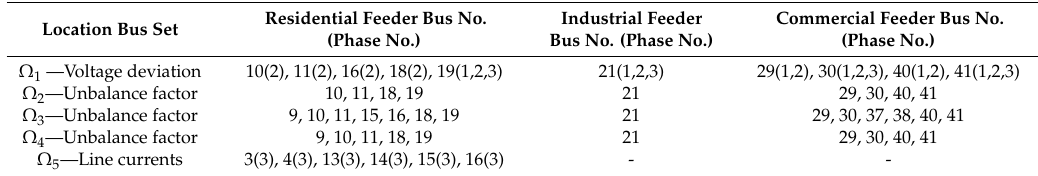
Table 8. Case Study 3: DESS allocation bus set (ABS).